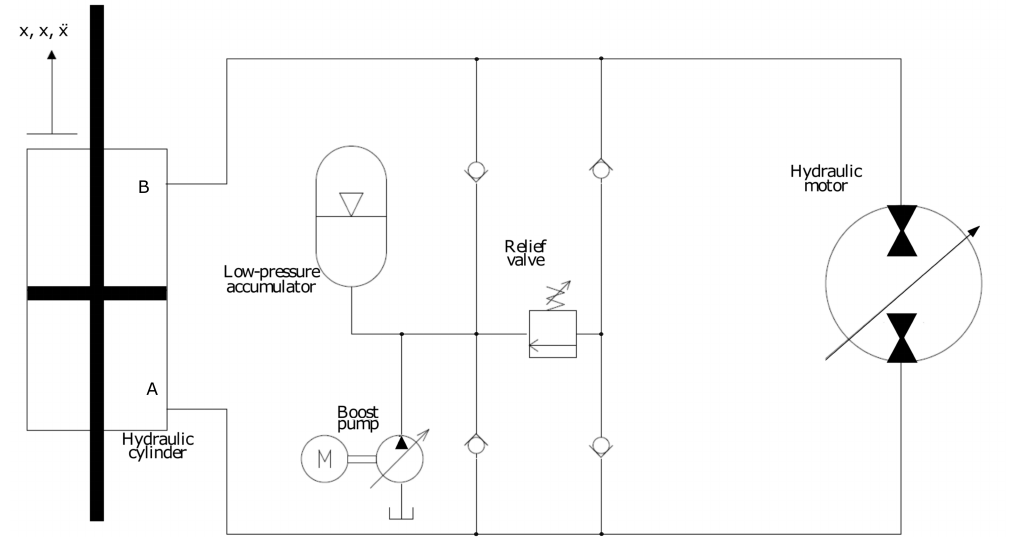
Figure 3. The scheme of a typical variable-pressure hydraulic transmission